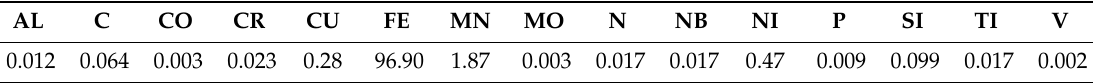
Table 1. Chemical composition of X100 pipeline steel (wt.%).